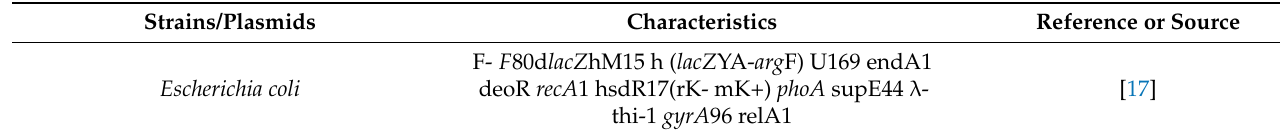
Table 2. Strains and plasmids used in this